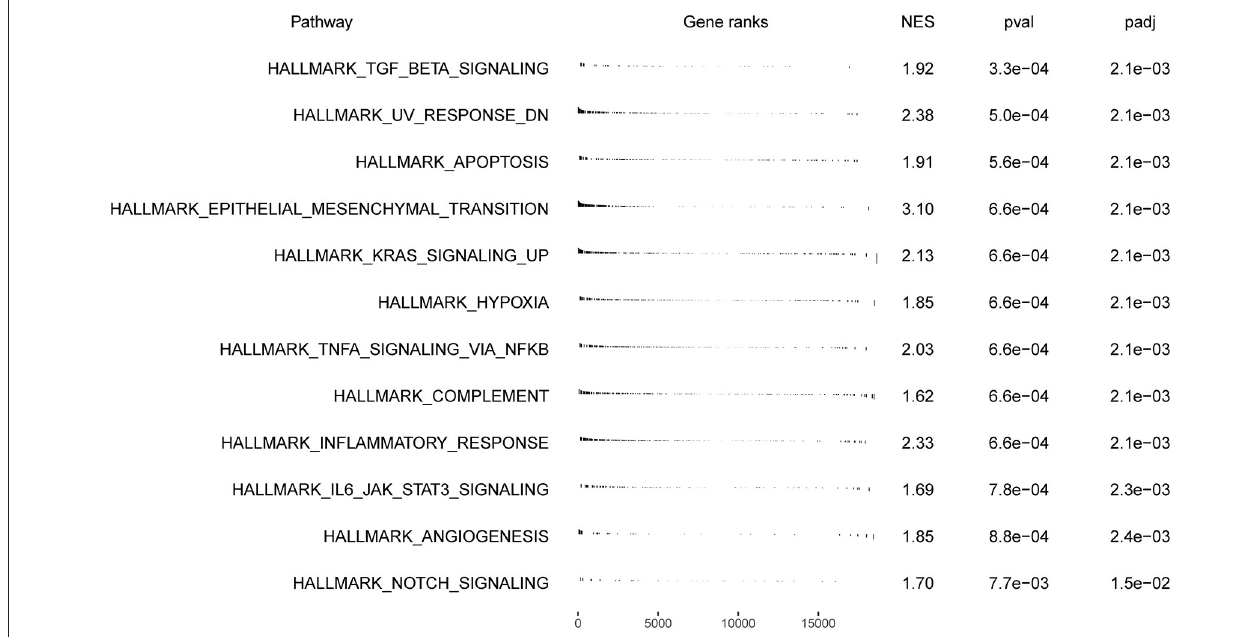
FIGURE 7 | Biological relevance between the VCAN and GC initiation and progression.